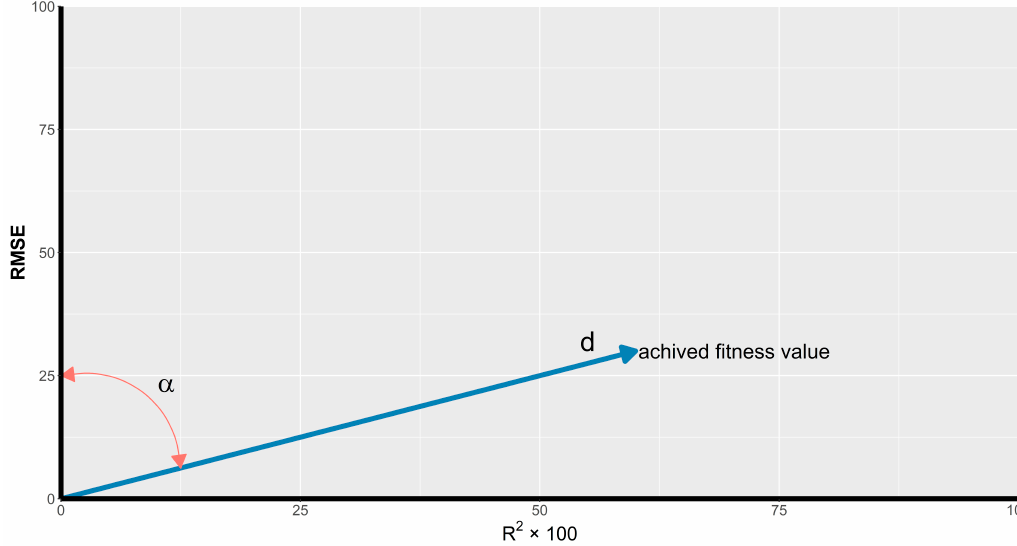
Figure 2. Applied fitness